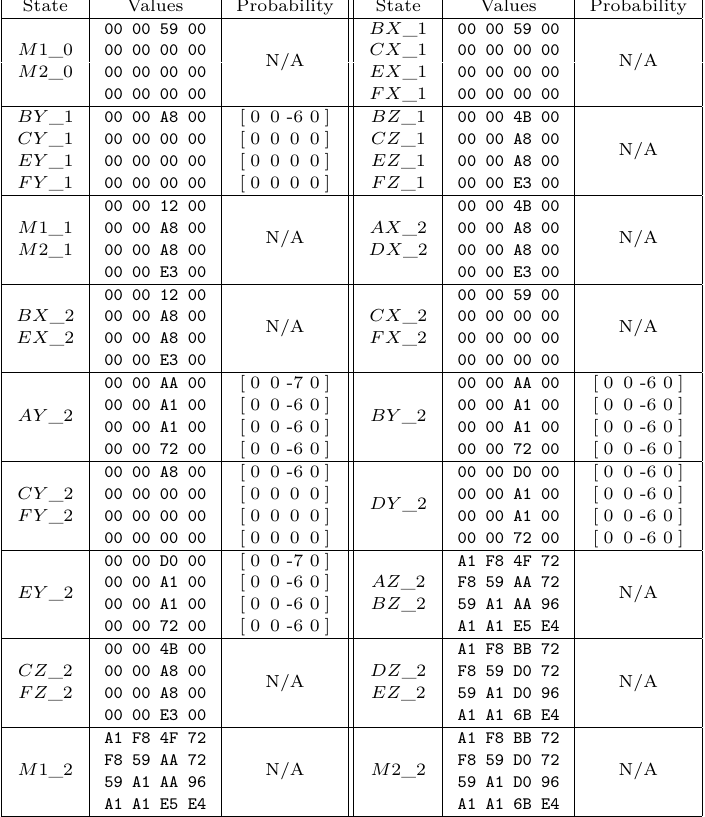
Table 12: 3-step differential characteristic for C1 with probability 2 − 134 . Differences are represented by hexadecimal numbers. “Probability” shows logarithm of the probability of the S-box differential transition in the corresponding byte of a particular